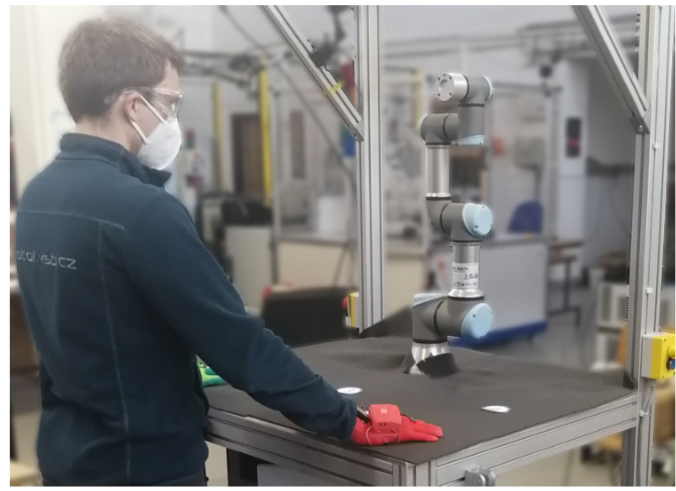
Figure 12. Performed user